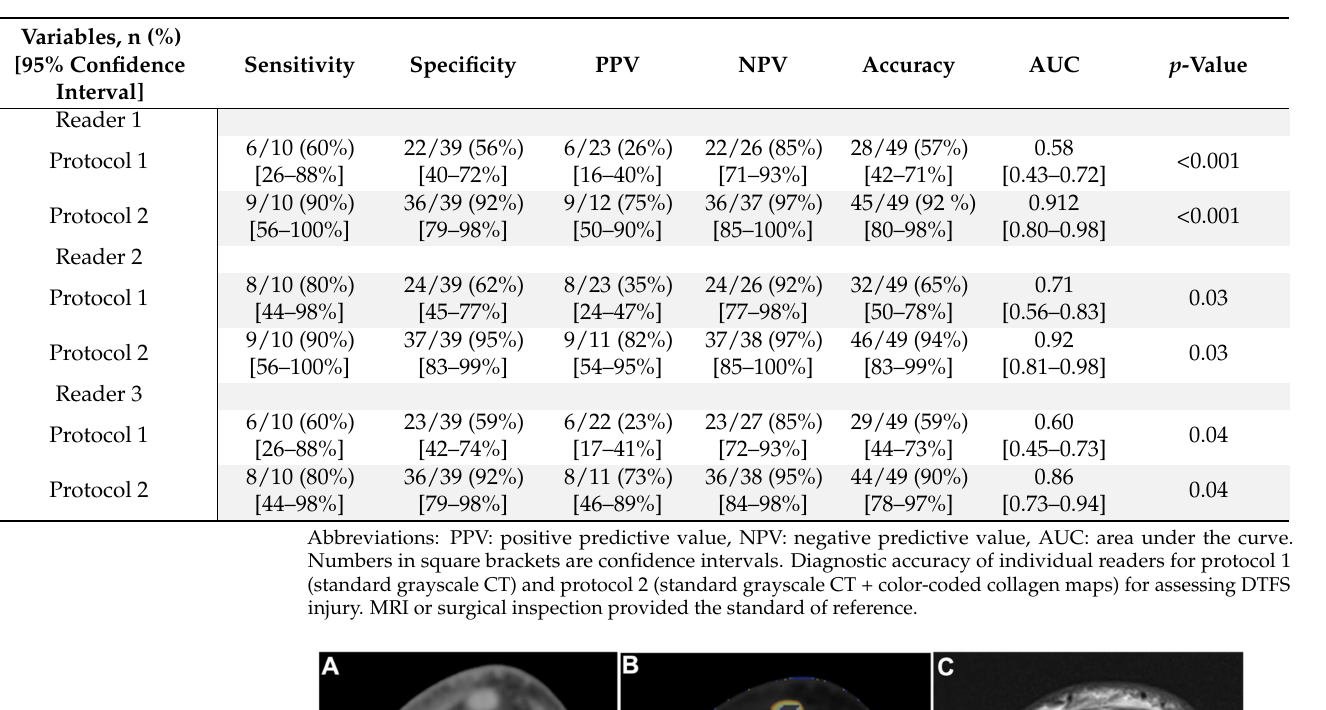
Table 3. Individual readings of diagnostic accuracy.